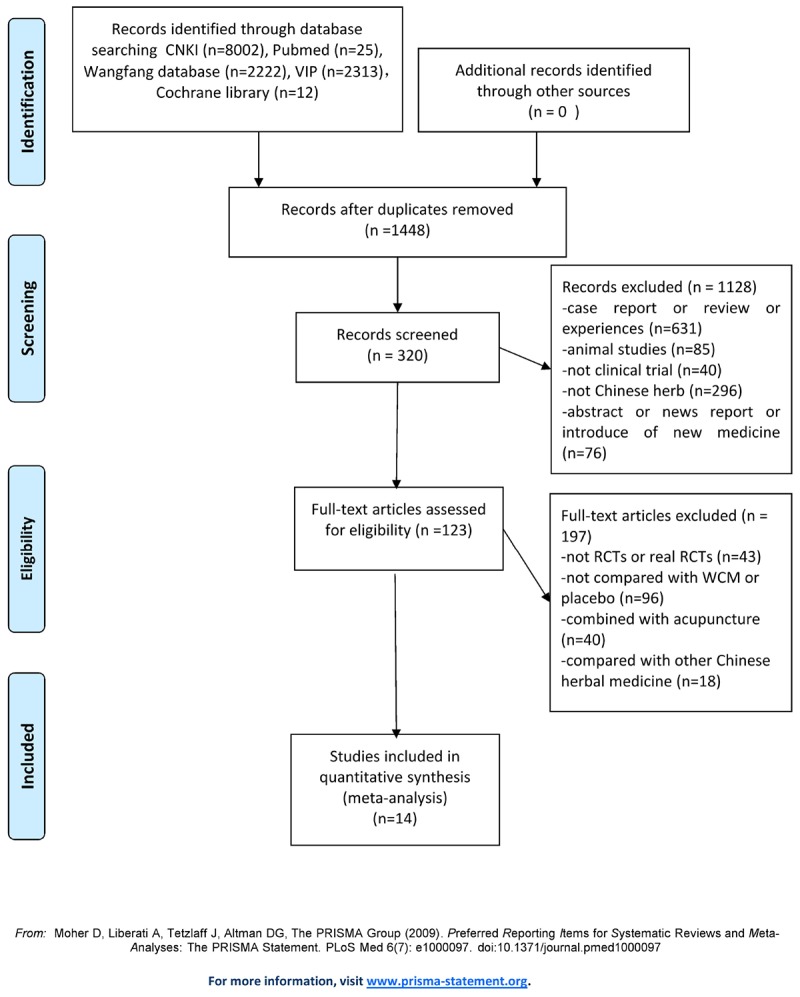
Flowchart of study screening.